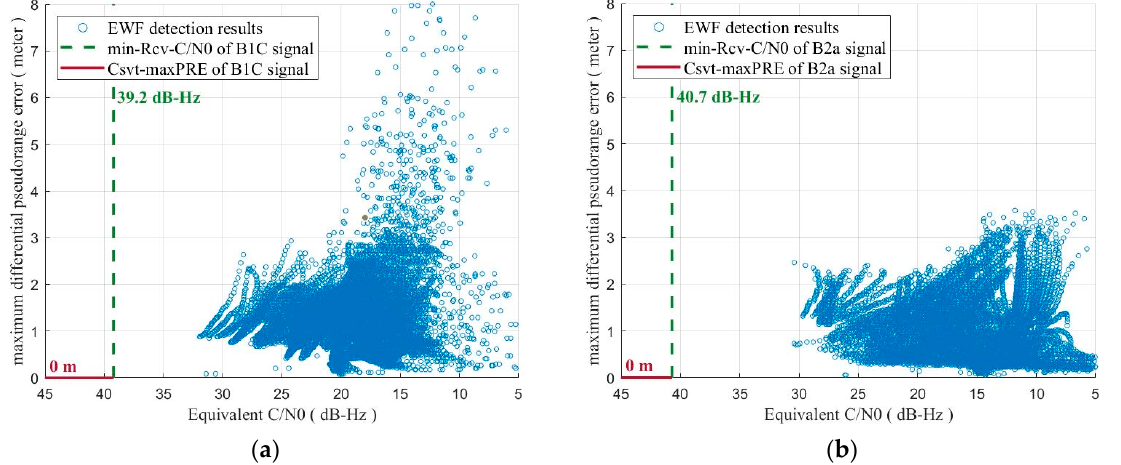
Figure 3. Evaluation results of the CDO-based SQM baseline algorithm with a sampling frequency of 72 MHz and bins of 0.025 B1-chips. ( a ) B1C signal; ( b ) B2a signal. 72 MHz and bins of 0.025 B1-chips. ( a ) B1C signal; ( b ) B2a